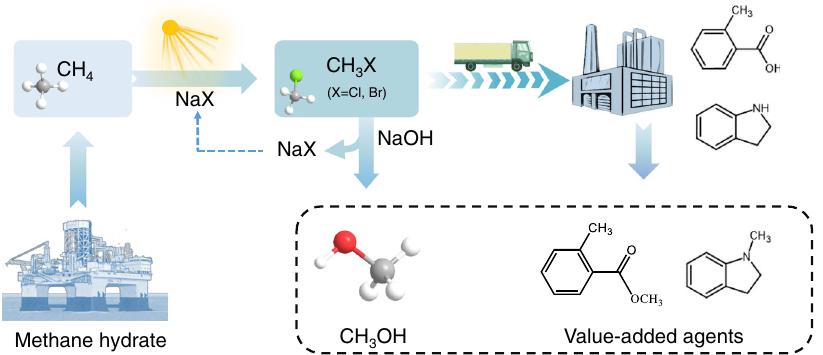
Fig.1|Schematicillustrationfortheproposedconcept. Thephotocatalyticmethanehalogenationusingalkalihalideasahalogenationagentatroomtemperature,and the successive transformations into fuels and